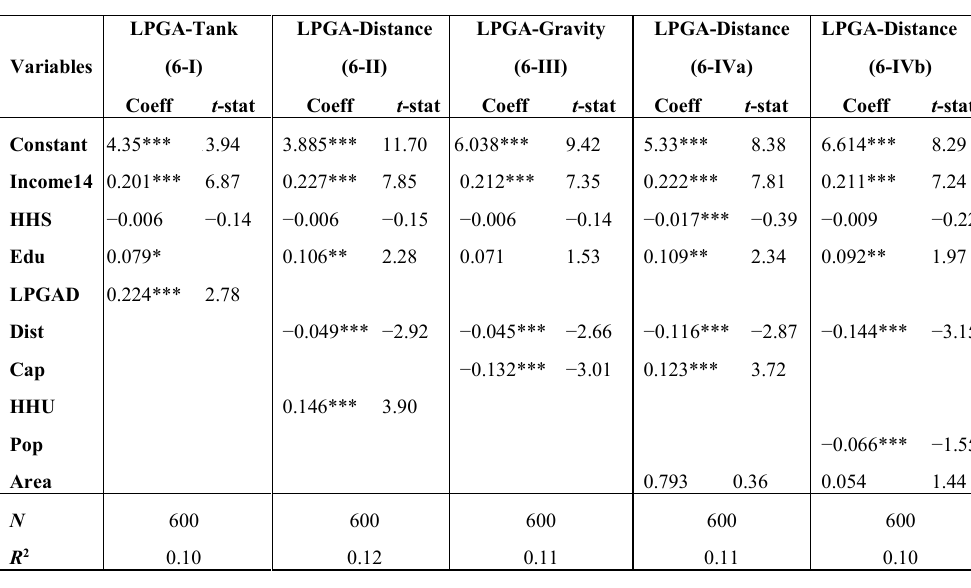
Table 11. Energy Access